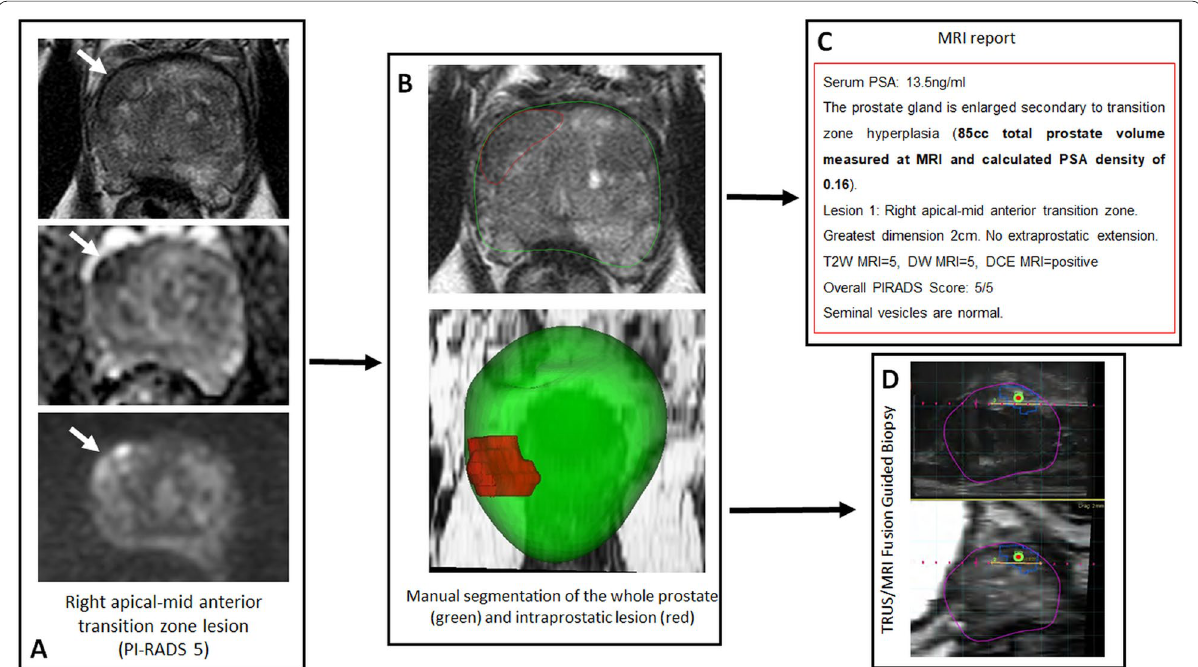
Fig. 2 The potential impact of AI-driven prostate segmentation on the workflow of the radiologist. A 6-year-old male patient with a serum PSA of 13.5 ng/mL: multiparametric MRI (T2-weighted sequence, ADC map; and diffusion-weighted image obtained with b segmentation or AI for total prostate organ and lesion detection/segmentation may be run ( B ); segmentation outputs aid in calculation of variables such as PSA density and greatest lesion dimension and classification (AI can potentially assign PI-RADS scores or predict suspicion of extra-prostatic extension to generate the report ( C ); output segmentations can be used for registration to ultrasound for TRUS/MRI fusion guided biopsy ( D ). AI Artificial intelligence, ADC Apparent diffusion coefficient, MRI Magnetic resonace imaging, PI-RADS Prostate Imaging Reporting and Data System, PSA Prostate-specific antigen, TRUS Transrectal